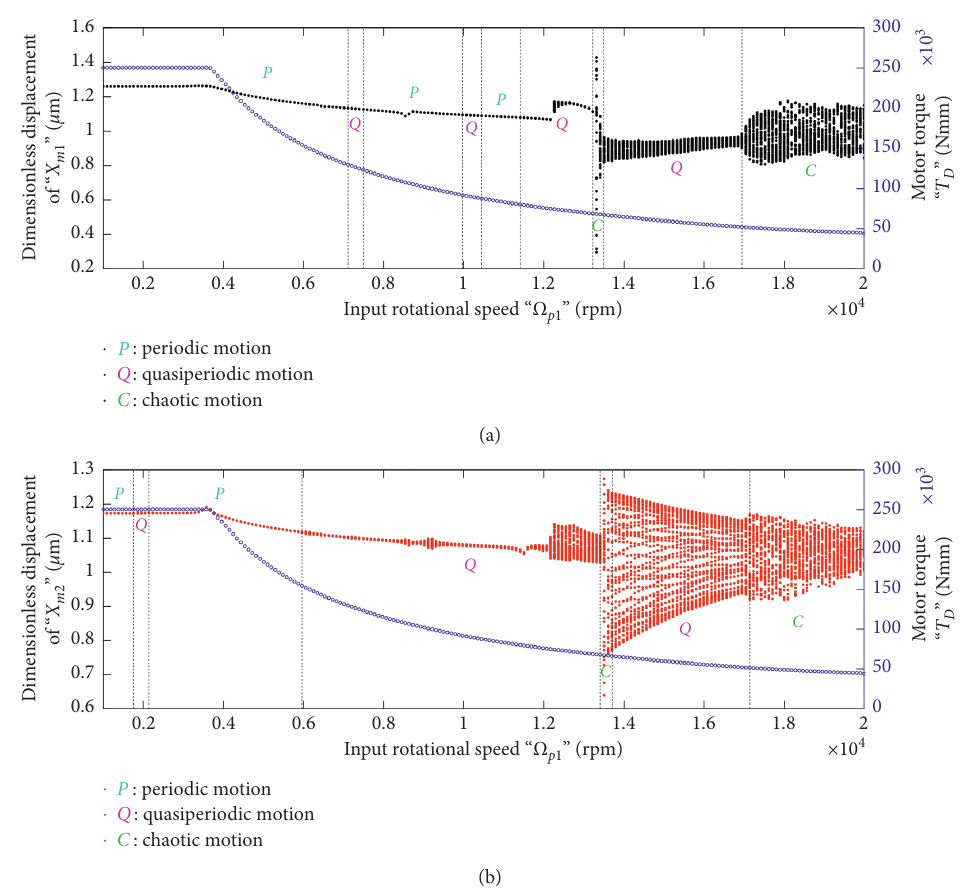
Figure 24: Backward bifurcation diagrams of system under the motor torque fluctuation of T